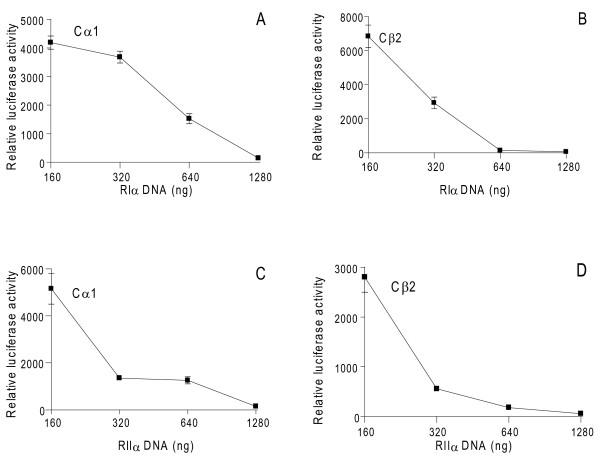
Expressed RIα and RIIα inhibit Cα1- and Cβ2-dependent CREB phosphorylation in a dose-dependent manner. 293T cells were co-transfected with increasing amounts (0-1280 ng) of either pDeRIα (A and B) or pExRIIα (C and D) and a fixed amount of pDeCα1 (300 ng, A and C) or pDeCβ2 (1400 ng, B and D). Cells were harvested after 24 hours and cell extracts adjusted to 1 mg total protein/mL and assayed at 560 nm for PKA-specific phosphorylation of CREB measured as CRE-activity. Data points represent relative luciferase activity +/- SD (n = 2-6).